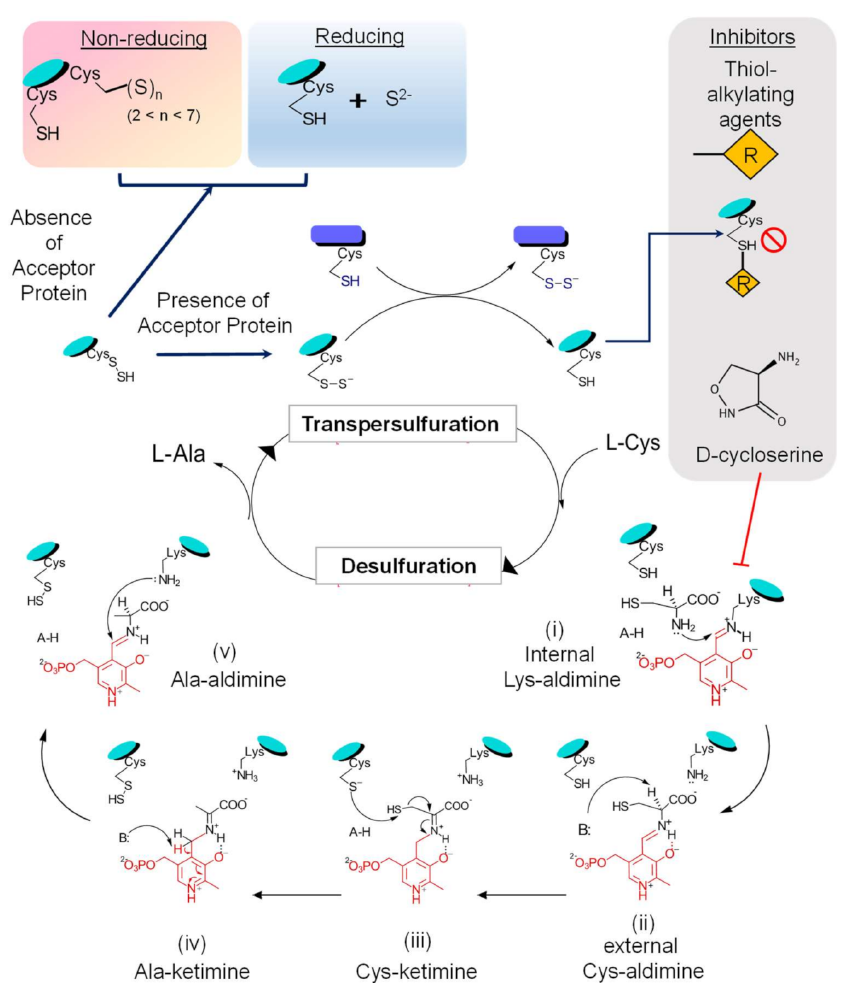
Figure 4. Schematic representation of the CSD reaction mechanism. The enzymatic activity of CSD can be divided into two phases: firstly, desulfuration of substrate L-cysteine and formation of the enzyme-bound persulfide intermediate, followed by the transfer of persulfide to its acceptor proteins, transpersulfuration. During the first phase of the reaction, the covalently bound cofactor-PLP acts as an electron sink and aids in the nucleophilic attack and the concomitant S-abstraction. This reaction proceeds via the formation of several reactive intermediate steps. The outcome of transpersulfuration can depend on the adjacent redox environment and the availability of S-acceptor proteins. On interaction with S-acceptor proteins, there is a transfer of the CSD-bound persulfide to the reactive thiol of an active site cysteine residue in the acceptor protein. However, in the absence of acceptors, the persulfide can get released as S 2 − /H 2 S under reducing conditions or form polysulfide species S n (2 < n < 7) on an adjacent free thiol under non-reducing conditions. Furthermore, the activity of CSD can be inhibited by thiol-alkylating agents (such as N-ethylmaleimide, iodoacetamide) by irreversibly modifying the thiol group of the active cysteine residue. CSDs, being PLP-dependent enzymes, are inhibited by molecules that covalently interact with the PLP-moiety forming irreversible protein-inhibitor complexes (for example, D- or